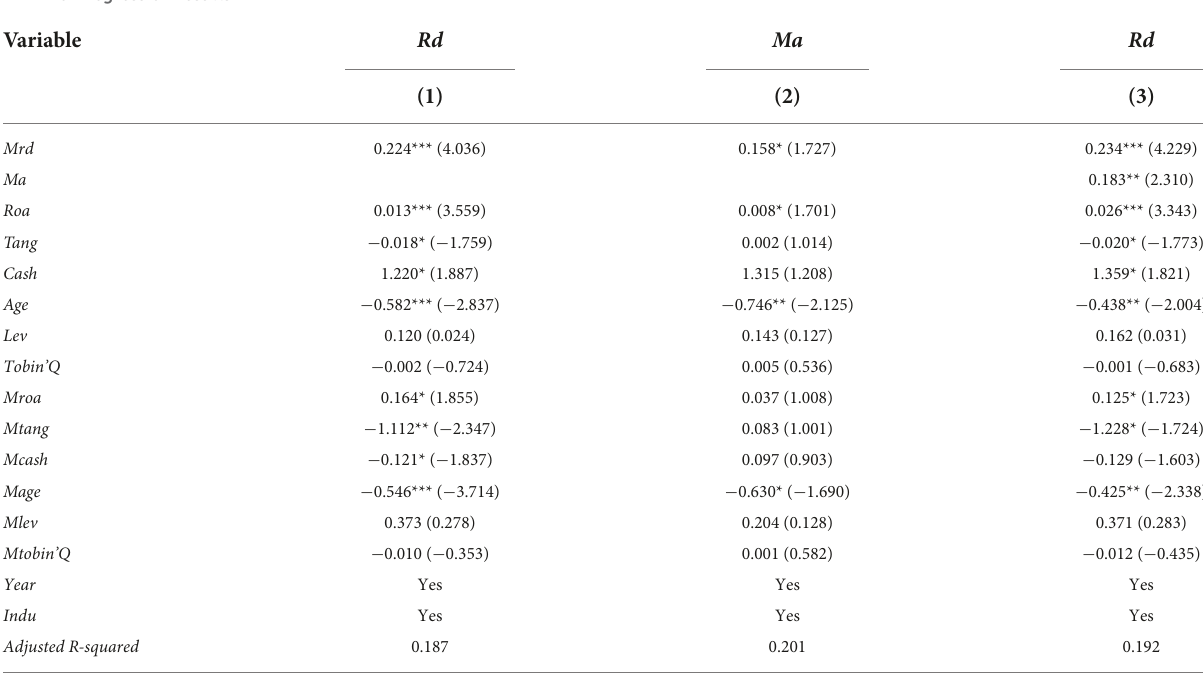
TABLE 3 Regression results.